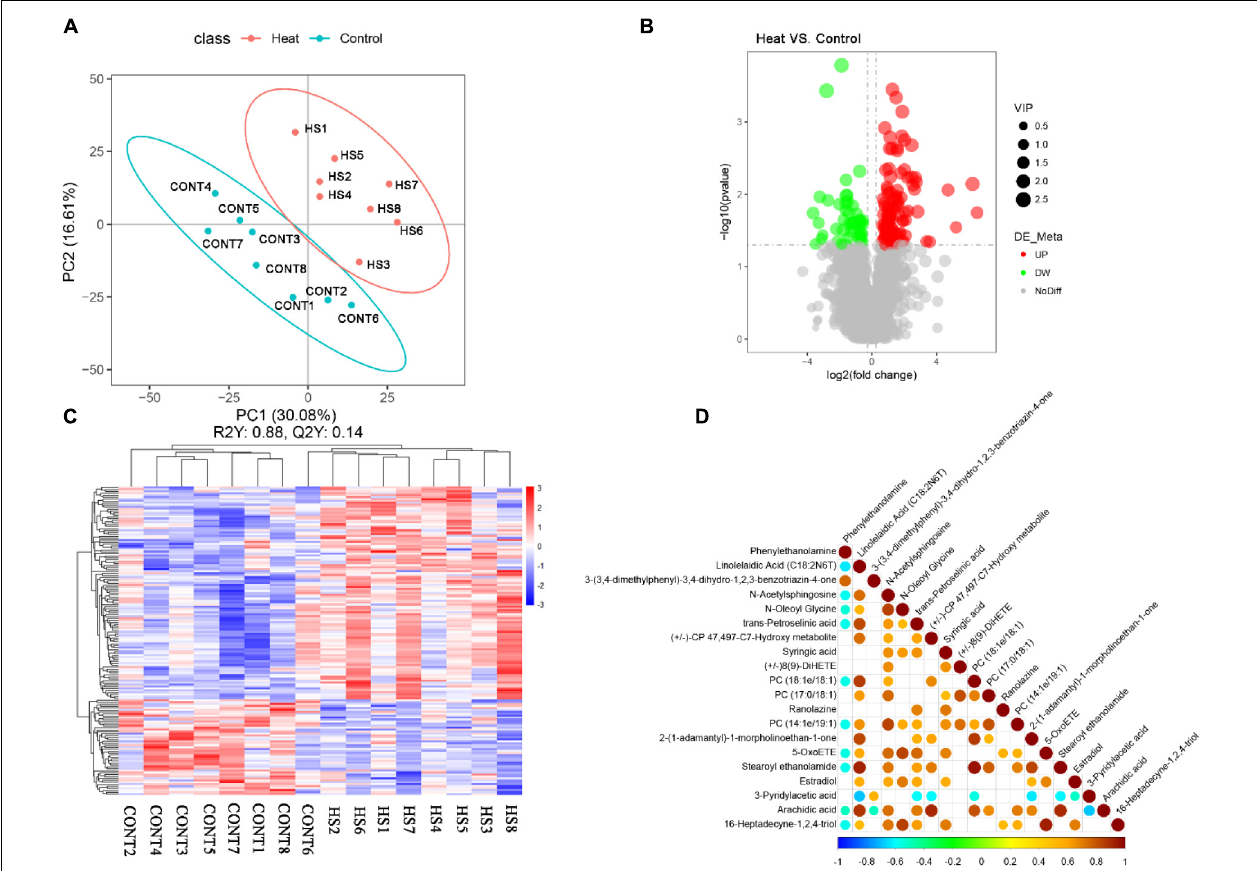
FIGURE 5 | Heat stress affected the vaginal metabolome of rabbit. (A) PLS-DA analysis of metabolites. Numbers and points in red and blue represent samples of the Control and Heat groups, respectively. (B) Volcano plot of metabolites. The abscissa represents the change in the relative concentrations of metabolites in different groups (log2fc), and the ordinate represents the difference significance level [–log10 ( p -value)]. Each point in the figure represents a metabolite; the size of the point represents the VIP value. Red and green points represent significantly up- and downregulated metabolites, respectively. Moreover, the gray point represents metabolites with no significant difference between Heat and Control groups. (C) Hierarchical clustering of metabolites with significant differences. Red and blue represent higher and lower concentrations of metabolites, respectively ( p < 0.05). (D) Correlation analysis of the top 20 of significantly differential metabolites. Red and blue points represent the significantly positive and negative correlations, respectively ( p < 0.05). The size of the point represents the absolute value of the correlation